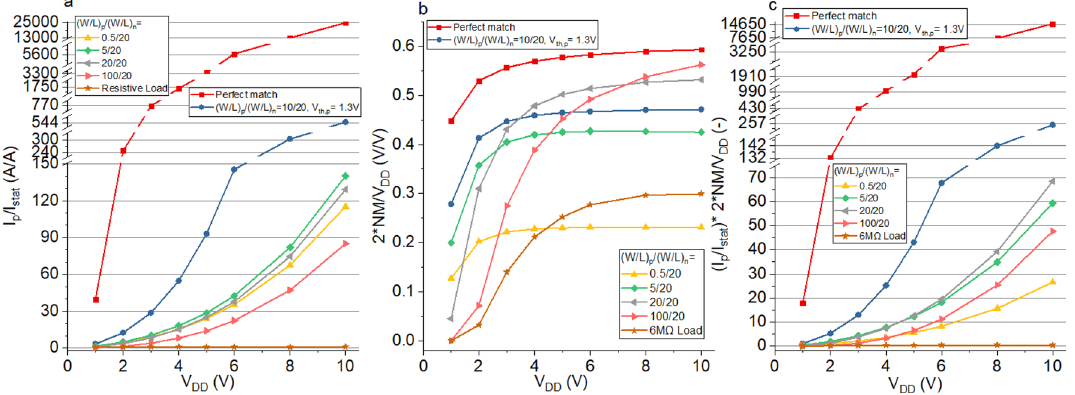
Figure 5. ( a ) I p / I stat and ( b ) normalised noise margin (2*NM/ V DD ) and ( c ) ( I p / I stat )*(2*NM/ V DD ) for the unipolar resistive load inverter, CMOS ISO-SnO inverter with different ( W/L ) ratios, threshold voltage shifted and perfectly matched cases.